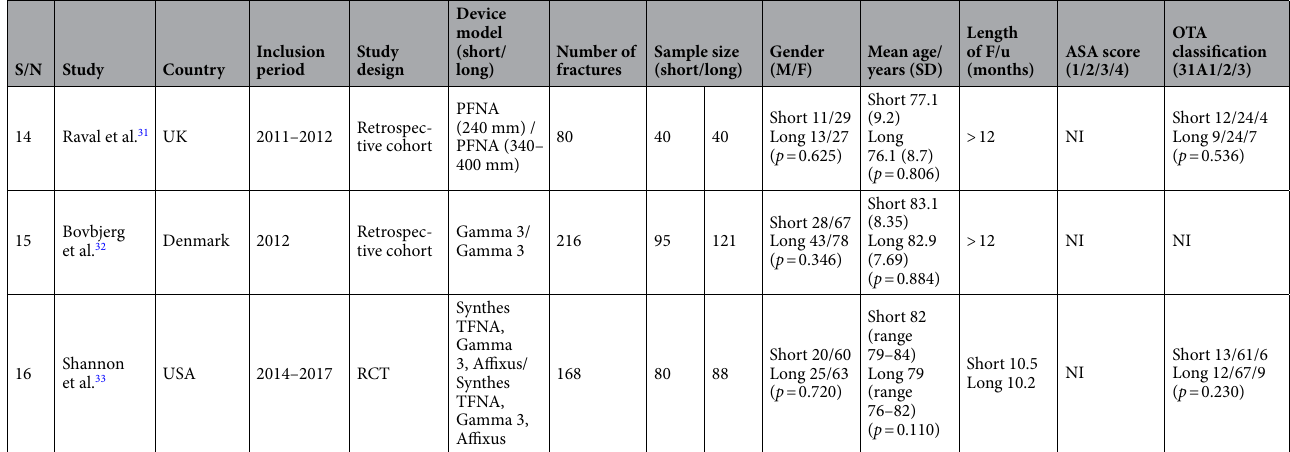
Table 1. Eligible studies, study characteristics, population demographics. RCT randomized controlled trial, NI no information, NC not possible to calculate. *Indicates statistically significant difference reported. All included studies were subject to an assessment of bias, with the revised Cochrane risk-of-bias tool (RoB 2) for the randomized controlled trials, and Risk-of-bias in Non-randomized Studies—of Interventions (ROBINS-I) tool for the retrospective cohort studies 34,35 . The detailed information on the assessment for bias is reported in Tables 2 and 3 respectively. None of the studies received external